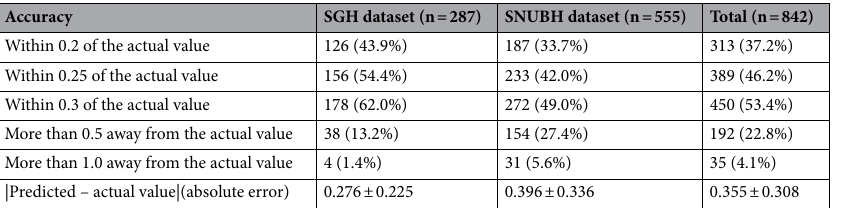
Table 2. Prediction of 8th-day prothrombin time international normalized ratio (PT INR) based on data from days 1–4 and assuming that a fixed dose of warfarin was administered from day 4 to 7. These predictions were compared to real data for patients who were administered the same dose of warfarin from day 4 to